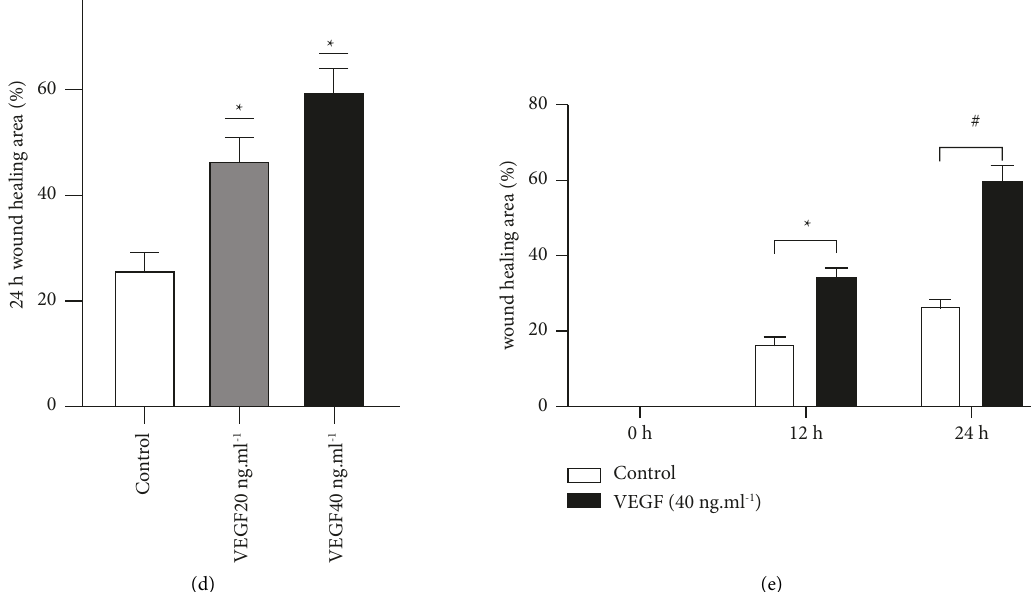
Figure 3: The effect of VEGF on ASMC migration was detected by wound healing assay. (1) The red auxiliary line indicates the scratch healing area of the control group and VEGF (40ng · ml − 1 ) group at 0, 12, and 24 h. (a) A representative picture. (b) Bar graph shows the healing rate of scratches in the control and VEGF groups at 12 and 24h. (c) Broken line diagram shows the scratch healing rate of the control and VEGF groups at 0, 12, and 24h, which is statistically significant between the groups ( P < 0 . 05). (2) The red auxiliary line is the control, VEGF 20ng · ml − 1 , and VEGF 40ng · ml − 1 groups (24h). (d) A representative picture. (e) A histogram of the control, VEGF 20ng · ml − 1 ,